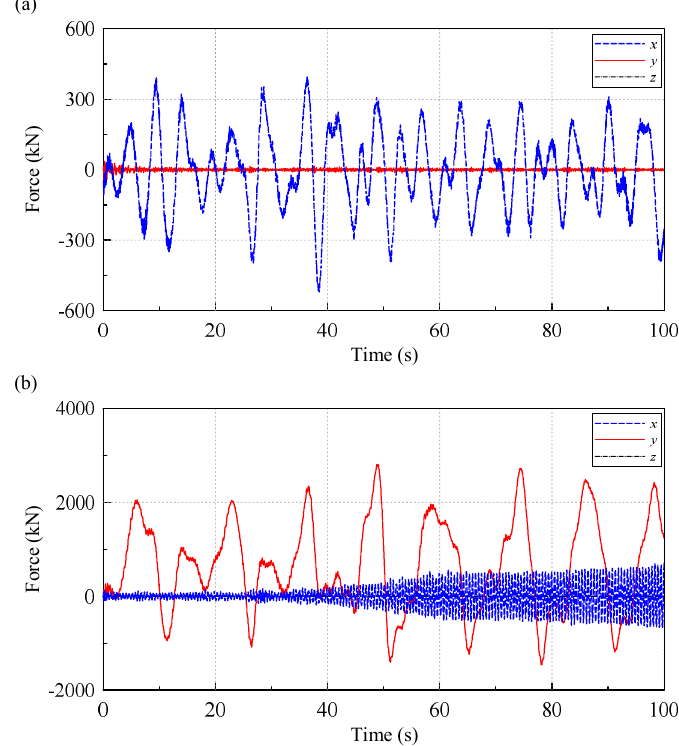
Figure 19. Force applied on the pile of the OWT: ( a ) normal wave condition; ( b ) extreme wave condition.